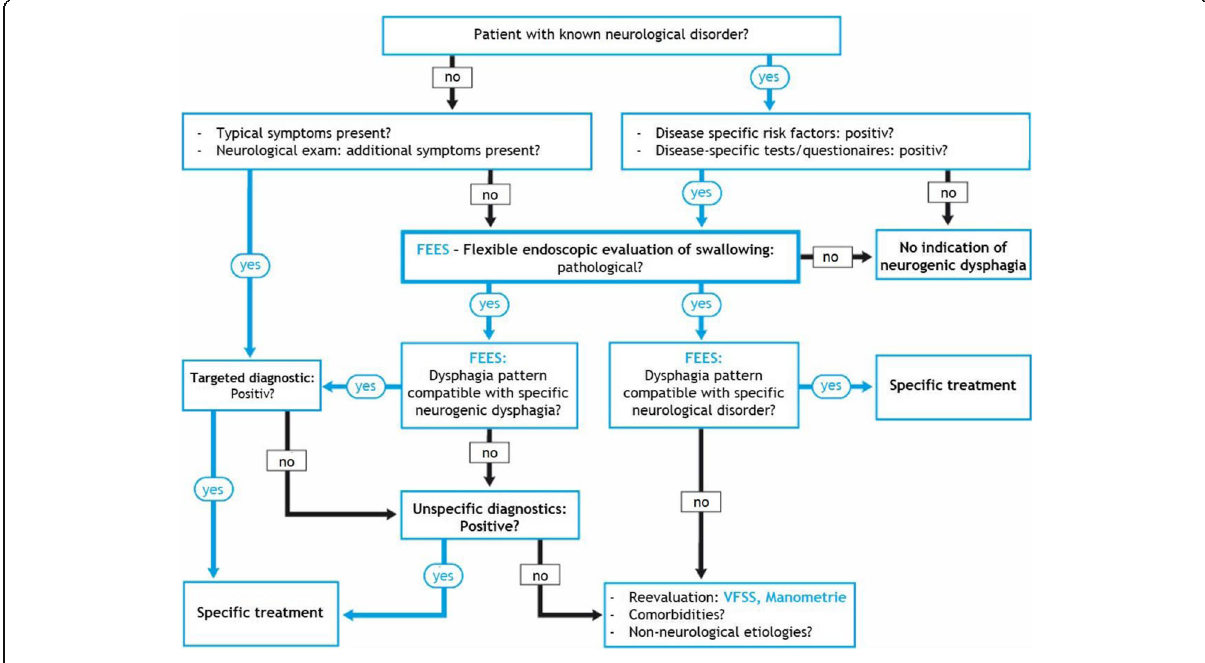
Fig. 1 Structured algorithm for the diagnosis of neurogenic dysphagia